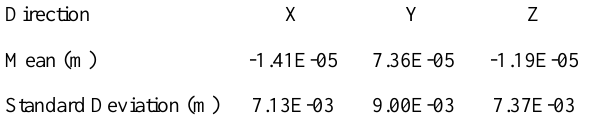
Table 2. Residual Errors associated with the